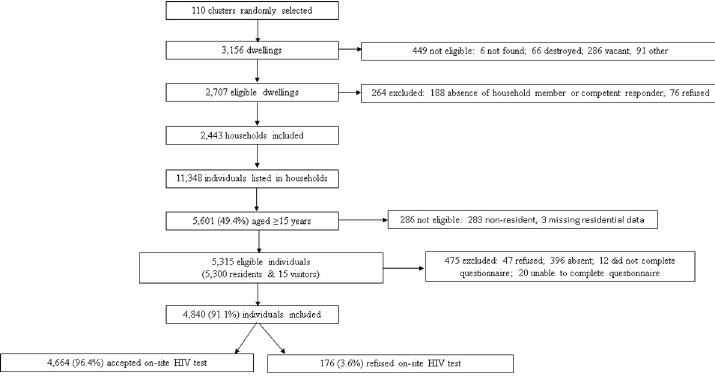
Fig 1. Flow chart of eligibility and inclusion of survey participants, Nsanje District, Malawi 2016.